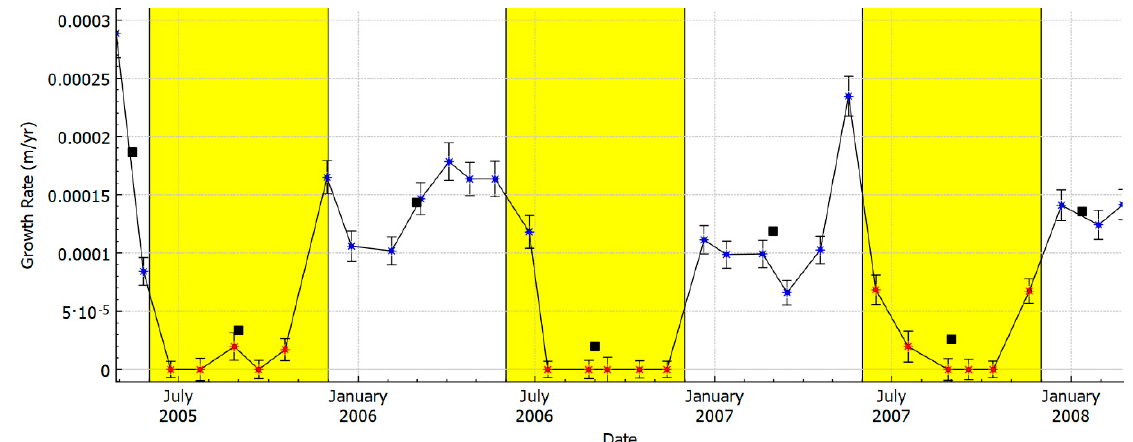
Figure 6. The user specified seasons for St. Michaels Cave, Gibraltar. Yellow shows the season of slow growth. See supplementary material for details.